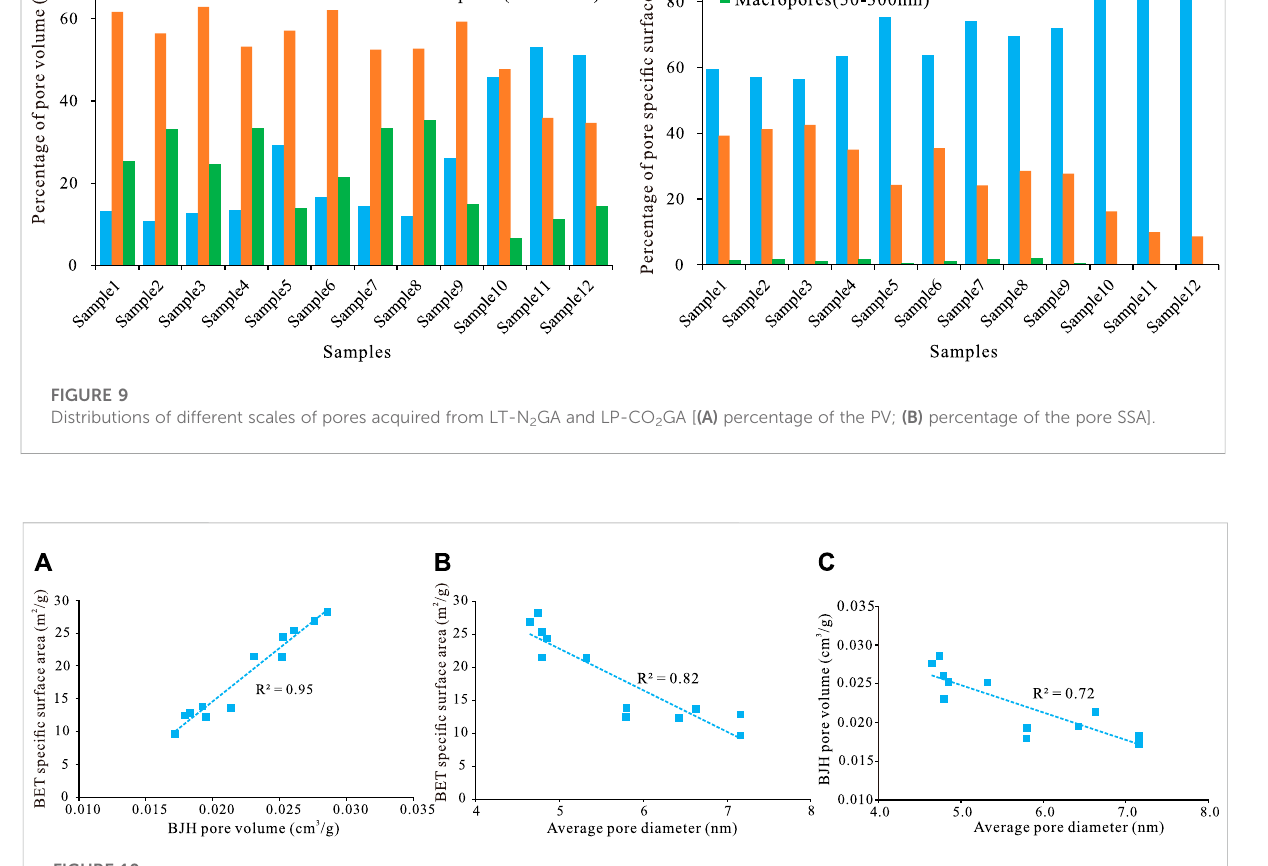
FIGURE 10 Correlation between pore structure parameters. [ (A) BET SSA vs BJH PV, (B) BET SSA vs APD; (C) BJH PV vs APD].